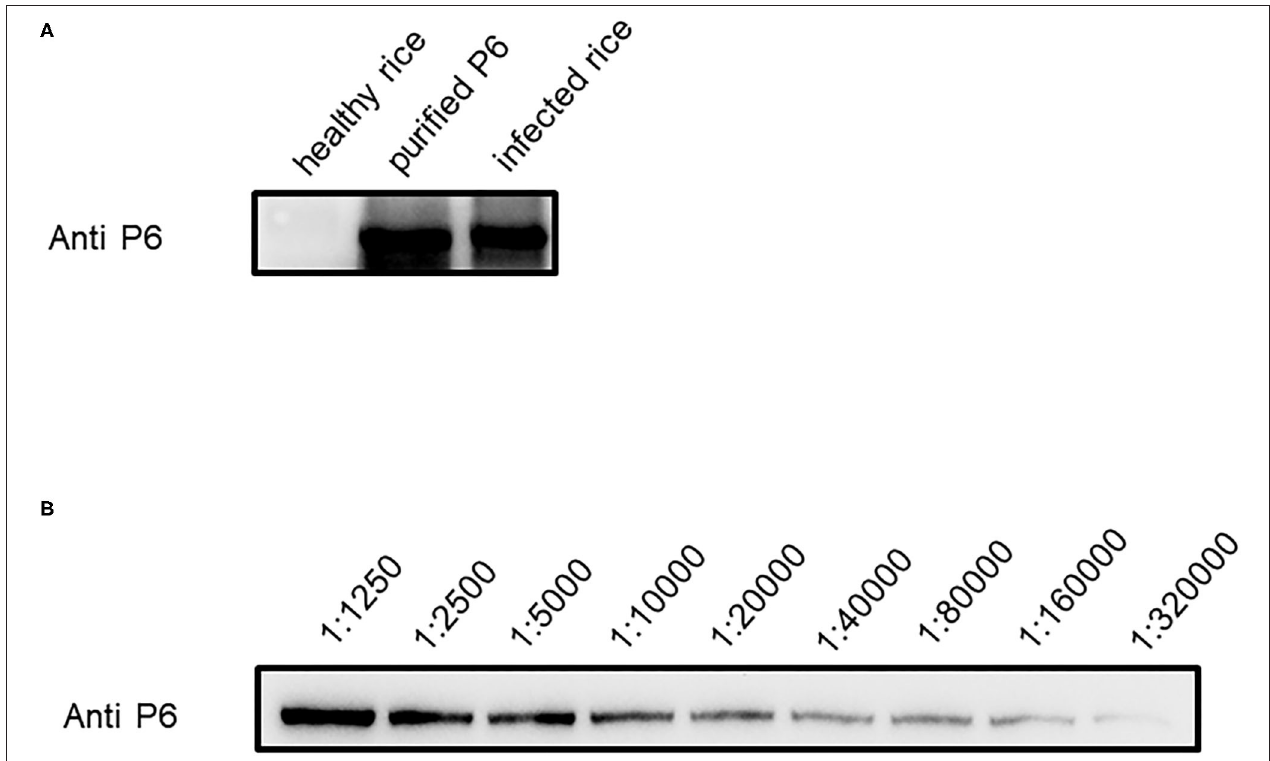
FIGURE 3 | Efficiency of P6 antibody in detecting SRBSDV. (A) SRBSDV detection of P6 antibody in healthy rice, protein antigen, and infected rice. (B) SRBSDV detection sensitivity of P6 antibody. Antigen diluted in series times such as 1:1250, 1:2500, 1:5000, 1:10000, 1:20000, 1:40000, 1:80000, and 1:160000 was used to test for P6 antibody detection